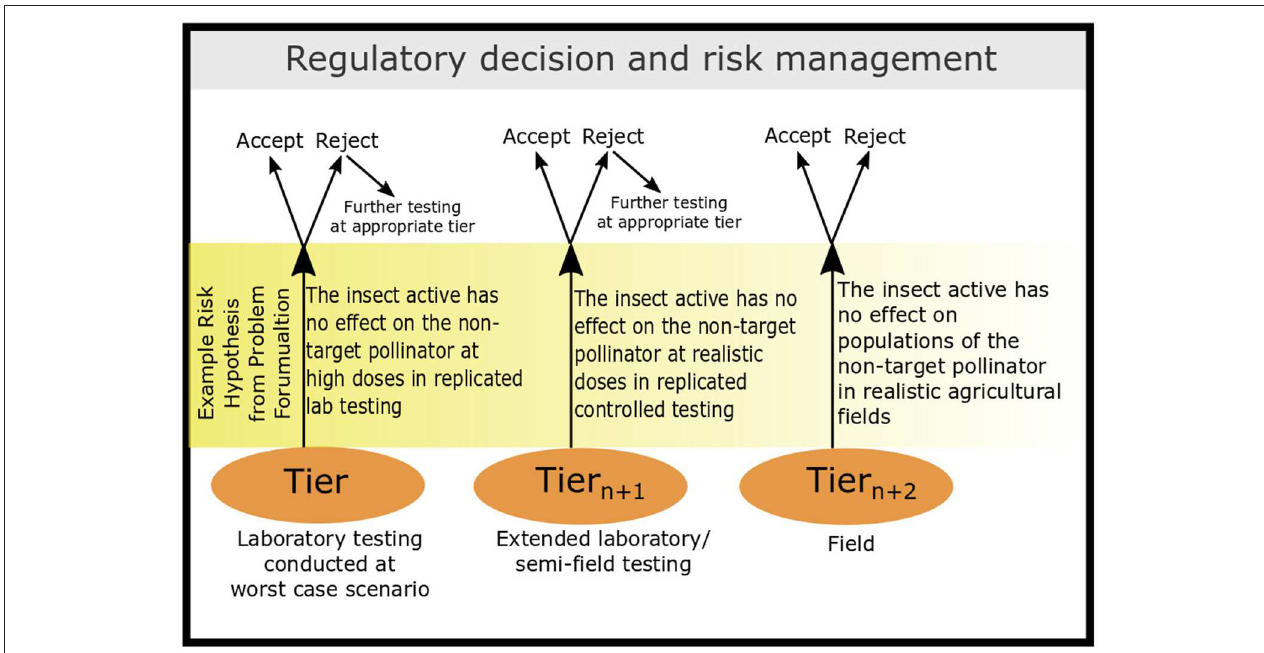
FIGURE 1 | This figure details the tiered structure of testing used during the ERA process. This is hypothesis-based testing, where the initial tests are conducted at doses higher than what is encountered in a natural setting to simulate a worst-case scenario exposure. Example risk hypotheses are provided for NTOs to demonstrate how this structure can be used to test sub-lethal effects. This figure was adapted from Romeis et al.